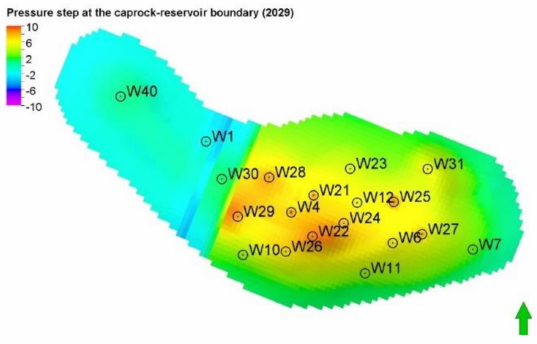
Figure 42. Distribution of pressure step across the caprock–reservoir rock boundary in